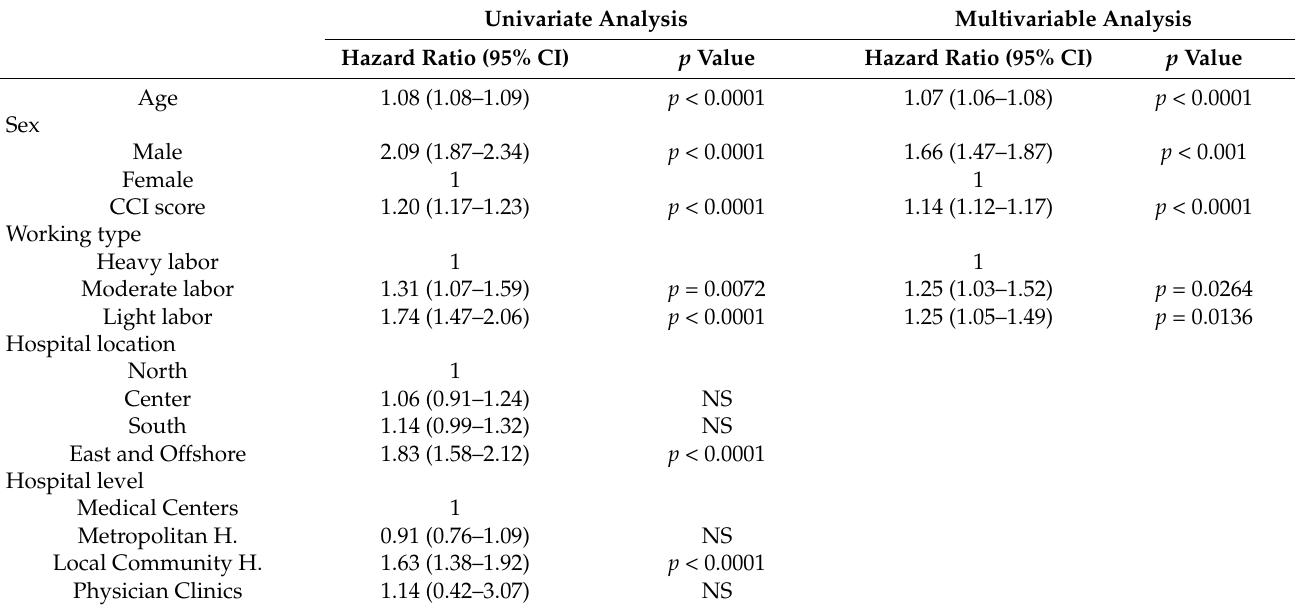
Table 4. Cox proportional hazards regression analysis for 5-year